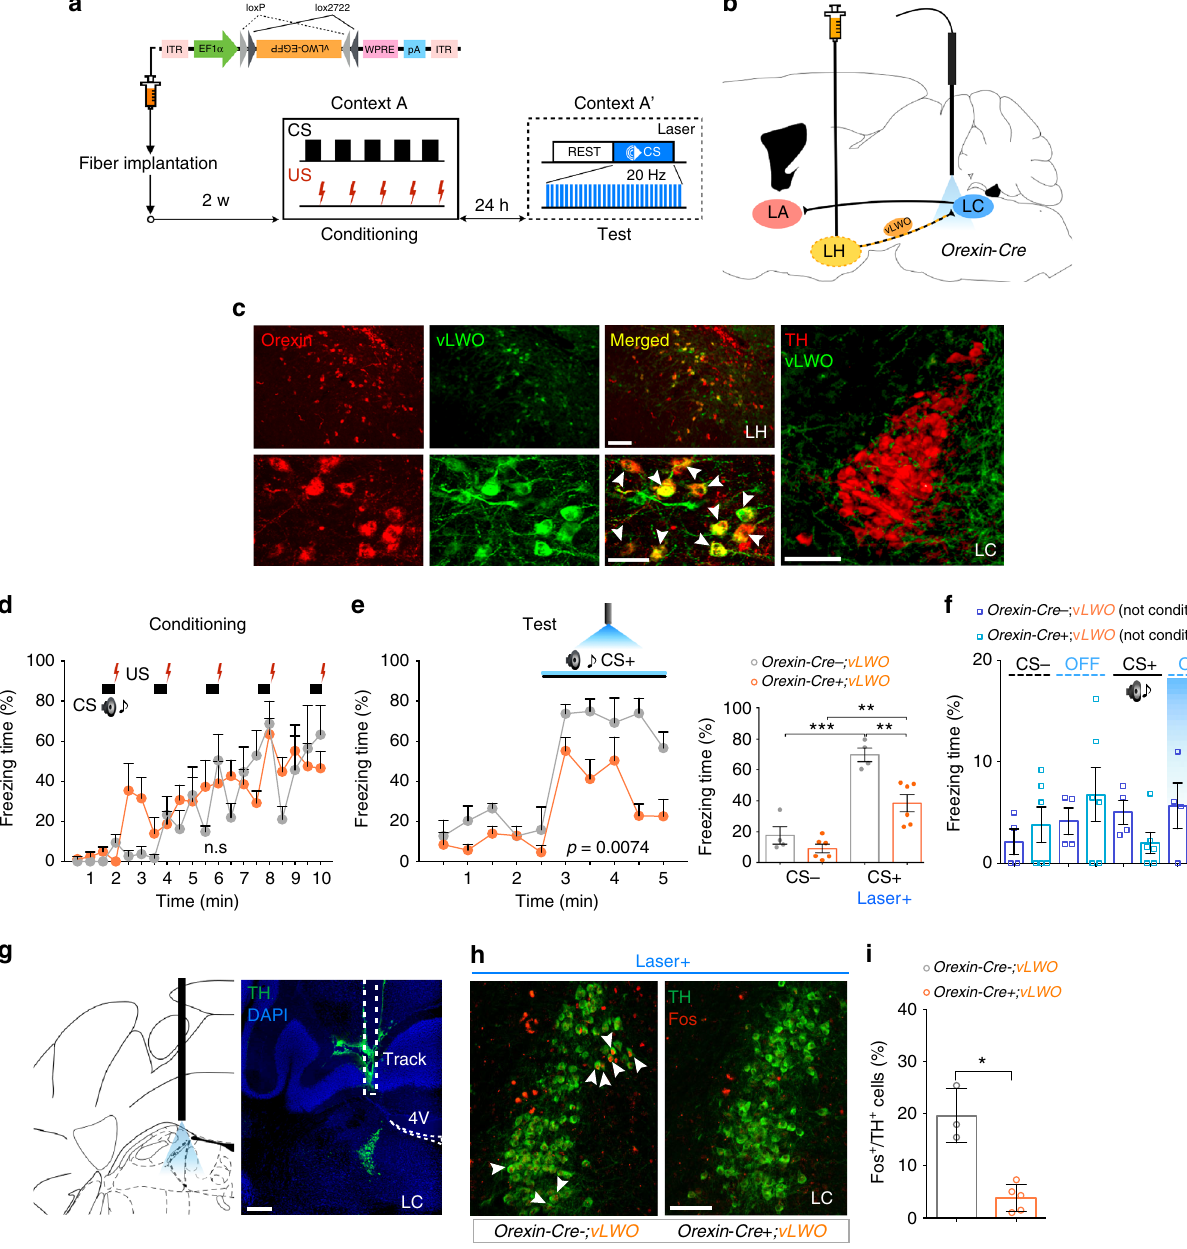
Fig. 4 Optogenetic inhibition of orexin LH → LC decreased cued fear expression. a Experimental protocol. b Schematic representation showing sites for injection of AAV 10 - FLEX-vLWO-EGFP and optic fi ber. c Histological examination showing that orexin neurons express vLWO. Orexin is stained red, while vLWO-EGFP is stained green. Merged cells were shown by white arrow heads. Scale bars: upper panel, 100 μ m; lower panel, 50 μ m; right panel, 100 μ m. Many vLWO-EGFP-positive fi bers are observed in the LC. d , e After cued fear conditioning, acute optogenetic inhibition reduced freezing behavior against CS. f Laser stimulation or auditory CS itself had no effect in naive mice. g Track of an optic fi ber implanted above the LC. Scale bar, 200 μ m. h Images showing Fos + /TH + cells (white arrow heads) in NA LC neurons with or without optogenetic inhibition of the orexin LH → LC pathway. Scale bar, 100 μ m. i Quanti fi cation of double-positive cells shown in the LC, suggesting that optogenetic inhibition of orexin LH fi bers reduced the activity of NA LC neurons. * p < 0.05, ** p < 0.01, *** p < 0.001. Values are mean ±